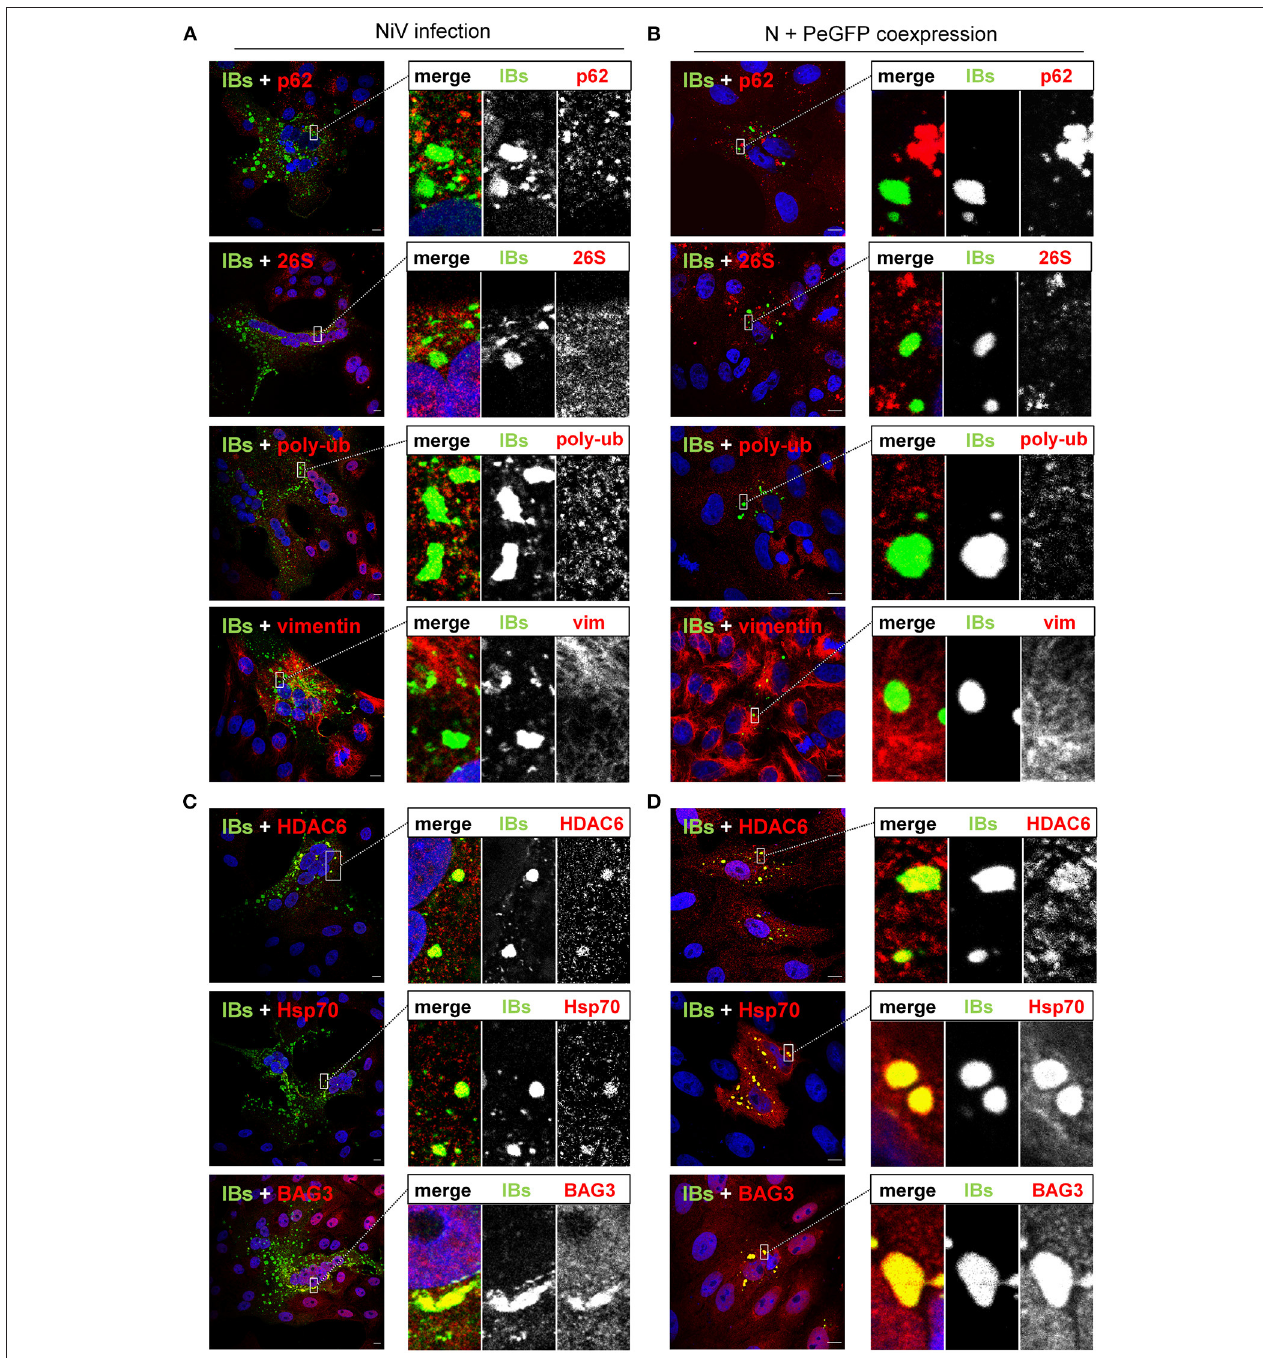
FIGURE 4 | Colocalization of IBs and aggresome markers. (A,C) Vero76 cells were infected with NiV at an MOI of 0.05. (B,D) Vero76 cells were transfected with plasmids encoding NiV N and NiV PeGFP. 24h later, infected or transfected cells were fixed with 4% PFA and permeabilized with Triton X-100. The indicated endogenous marker proteins were labeled with specific antibodies (red). IBs (green) were detected by a NiV N antiserum (A,C) or eGFP autofluorescence (B,D) . Nuclei were counterstained with DAPI (blue). Only merged images are shown. The boxed areas are displayed in a higher magnification together with the single channel greyscale images. Scale bars, 10 µ